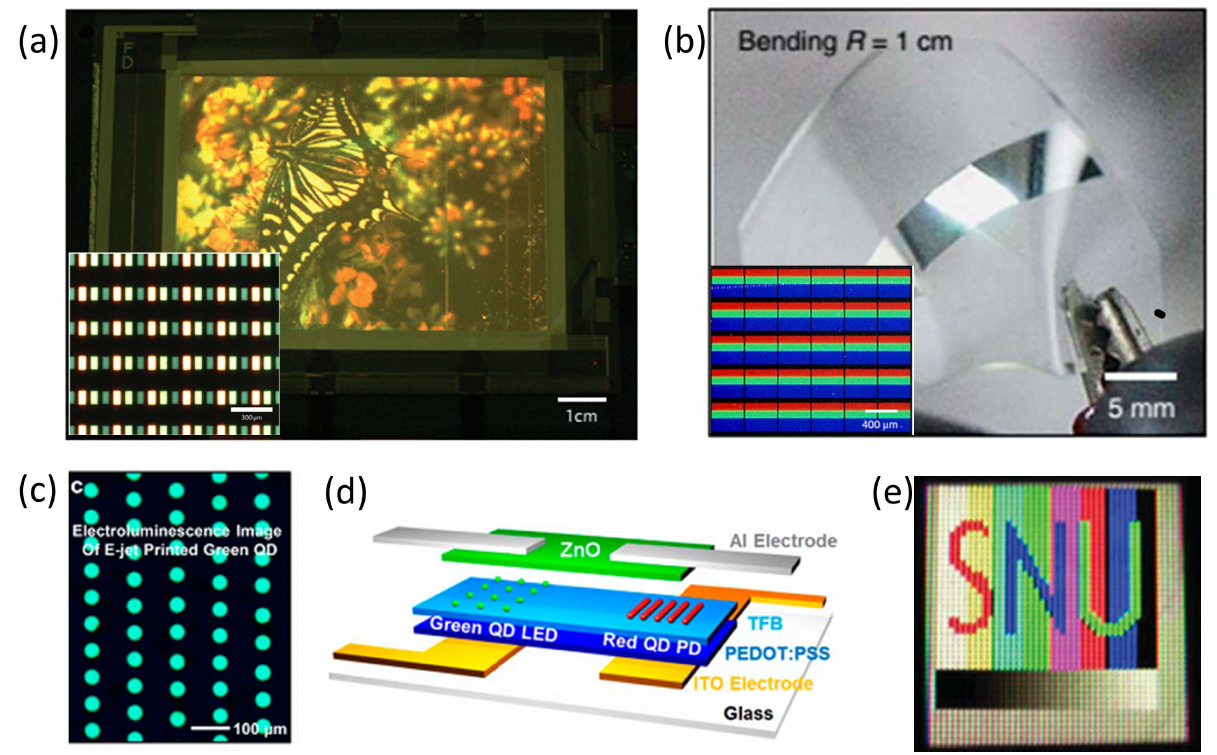
Figure 4: (a) A butterfly image illustrated by the electroluminescence of quantum dot (QD) display. Inset shows a close look at the elec- troluminescent display. Scale bars are 1 cm for the larger photograph and 300 µ m for the inset image. Reproduced with permission from Ref. [91], Copyright Nature Publishing Group. (b) Real color photograph of wearable QD display and the electroluminescence of the pix- els (inset). Reproduced with permission from Ref. [92], Copyright Nature Publishing Group. (c) Electroluminescence of the green QD